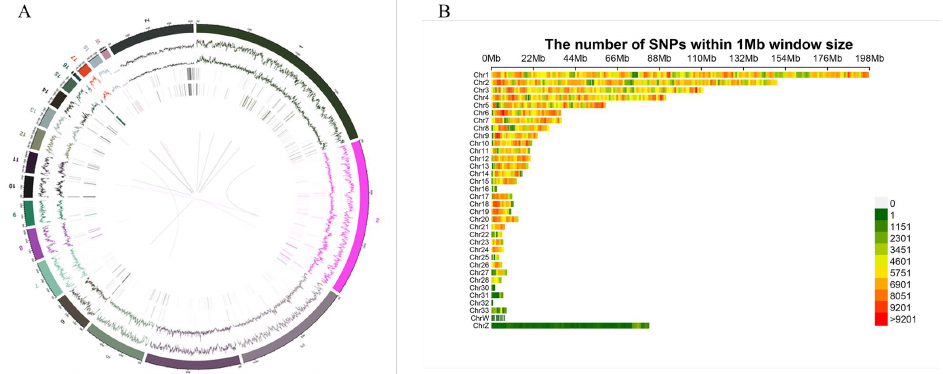
Figure 3. The distribution of variation in F2 populations ( A ) The distribution of variants within autosomal and sex chromosome of the chicken genome, from the outside to the inside of the circle, was SNP, Indel, SV, and CNV. ( B ) The distribution of SNPs within the 1 Mb window on autosomes and sex chromosomes of the chicken